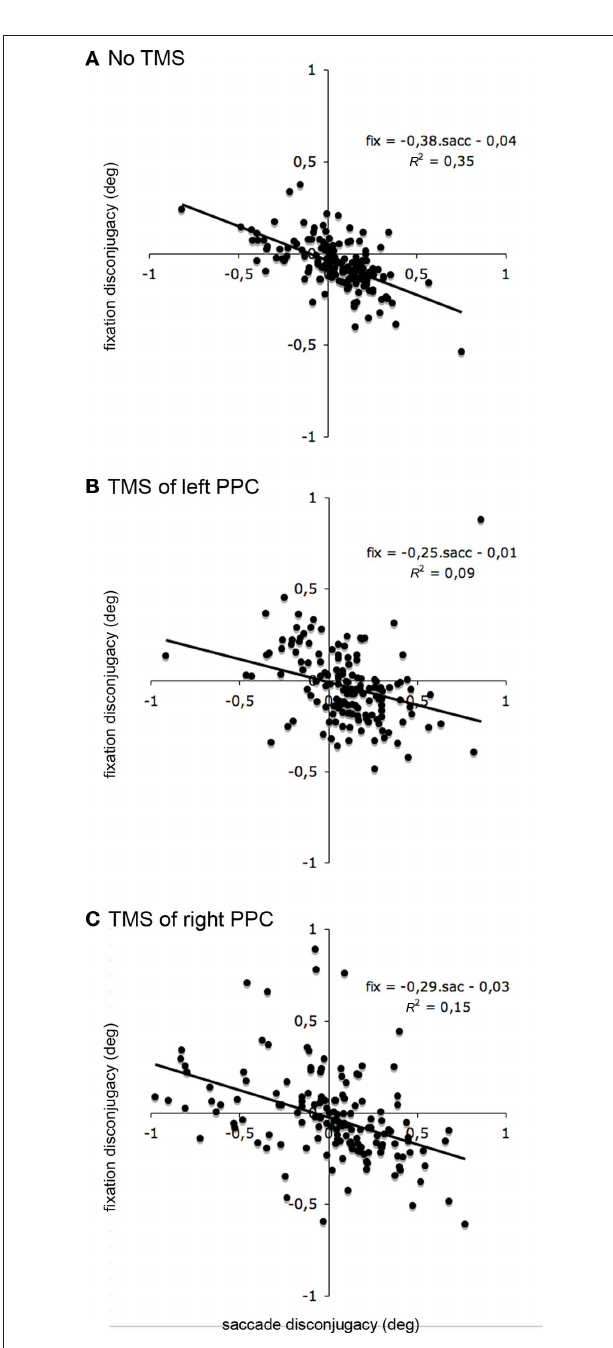
FiGure 3 | effects of single-pulse TMS on the link between saccade disconjugacy and fixation drift disconjugacy. Drift disconjugacy plotted against saccade disconjugacy for the saccade occurring in the 600 ms window, in the no-TMS, left PPC stimulation and right PPC stimulation. Note that outliers have been removed before